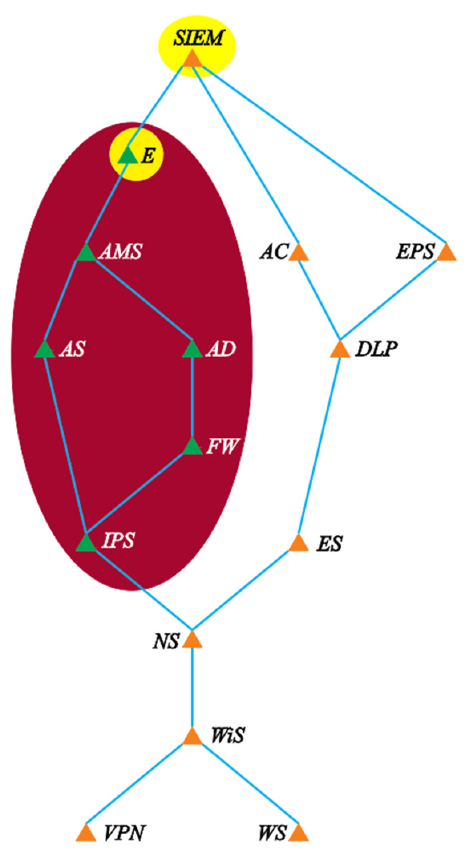
Figure 7. Hasse diagram for IVC-partial order-FR Ṝ .